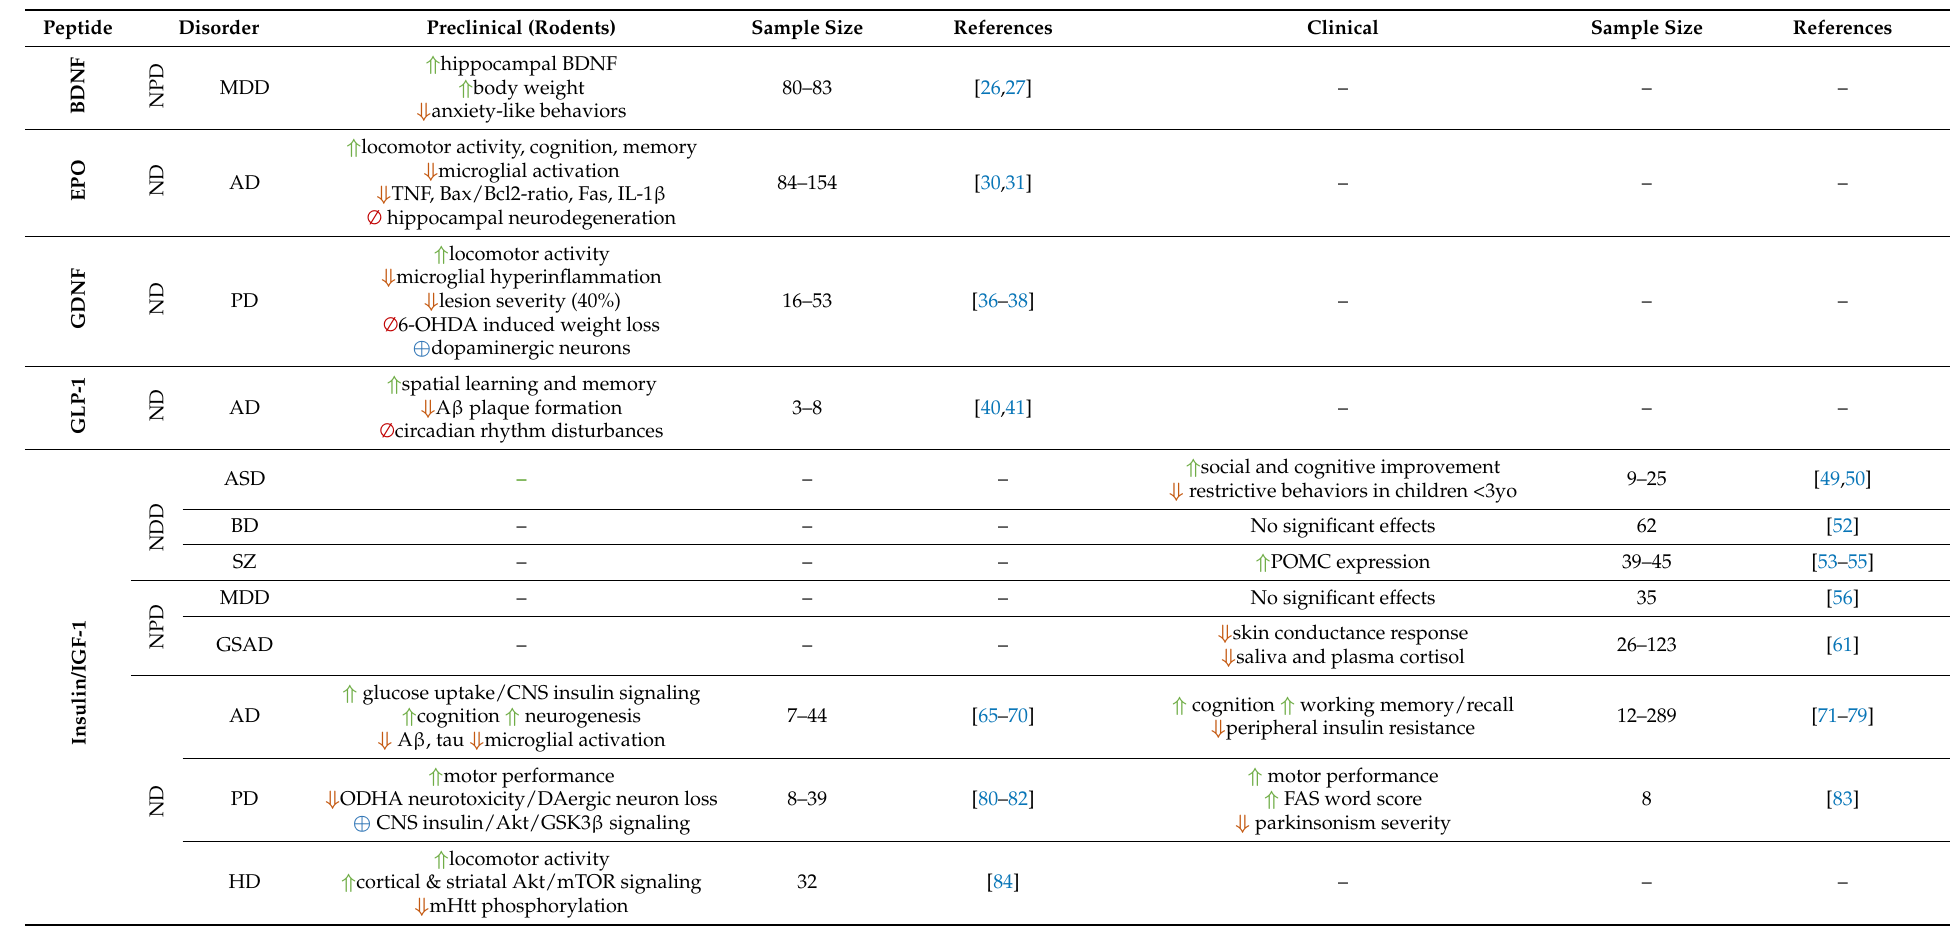
Table 1. Summary table of all significant intranasal peptide drug data as reviewed from literature, preclinically in rodent models and/or clinically in randomized controlled trials of varying design. Effects seen listed as: ⇑ = improved; ⇓ = reduced; ⊕ = restored; ∅ = eliminated/prevented. Subsections: NDD = neurodevelop- mental disorders; NPD = neuropsychiatric disorders; ND = neurodegenerative disorders. Disorders: ASD = Autism Spectrum Disorder; BD = Bipolar Disorder; SZ = Schizophrenia; MDD = Major Depressive Disorder; GSAD = Generalized/Social Anxiety Disorder; PTSD = Post-traumatic Stress Disorder; AD = Alzheimer’s Disease; PD = Parkinson’s Disease; HD = Huntington’s Disease; FTD = Frontotemporal